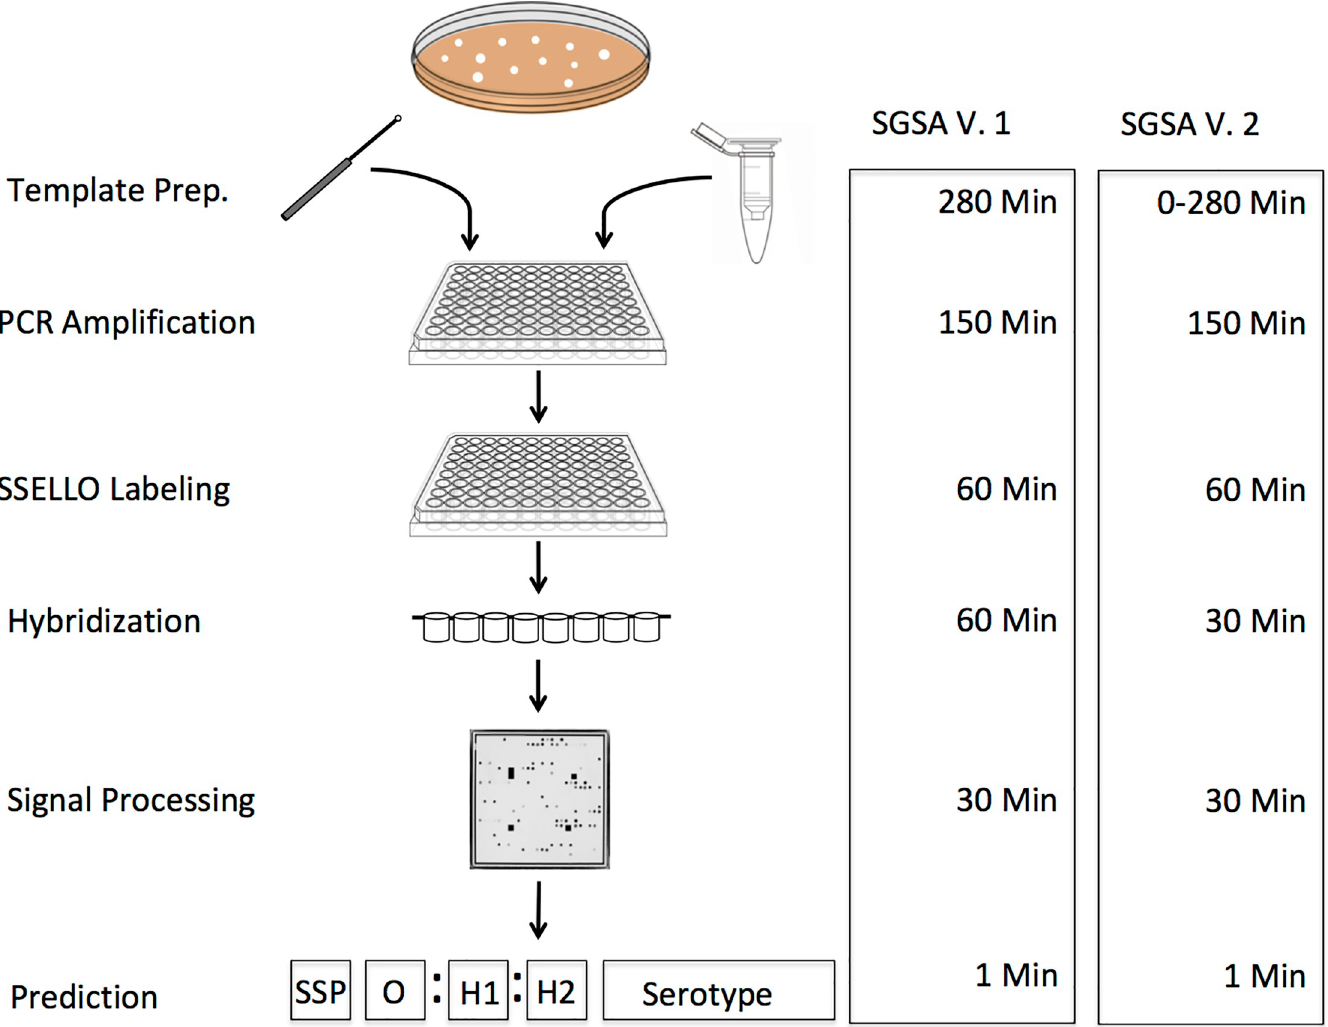
Fig 1. Workflow diagram outlining the process for both versions of the SGSA and the differences in processioning time between them. The workflow for the SGSA v. 2 consists of multiple small improvements, which increase the throughput of the assay and reduce the hands-on time required to process 96 samples. Colony PCR saves four hours of labor compared to DNA extraction on a 96 well plate, and up to 1.5 days considering time saved from not having to grow a broth culture from colonies.